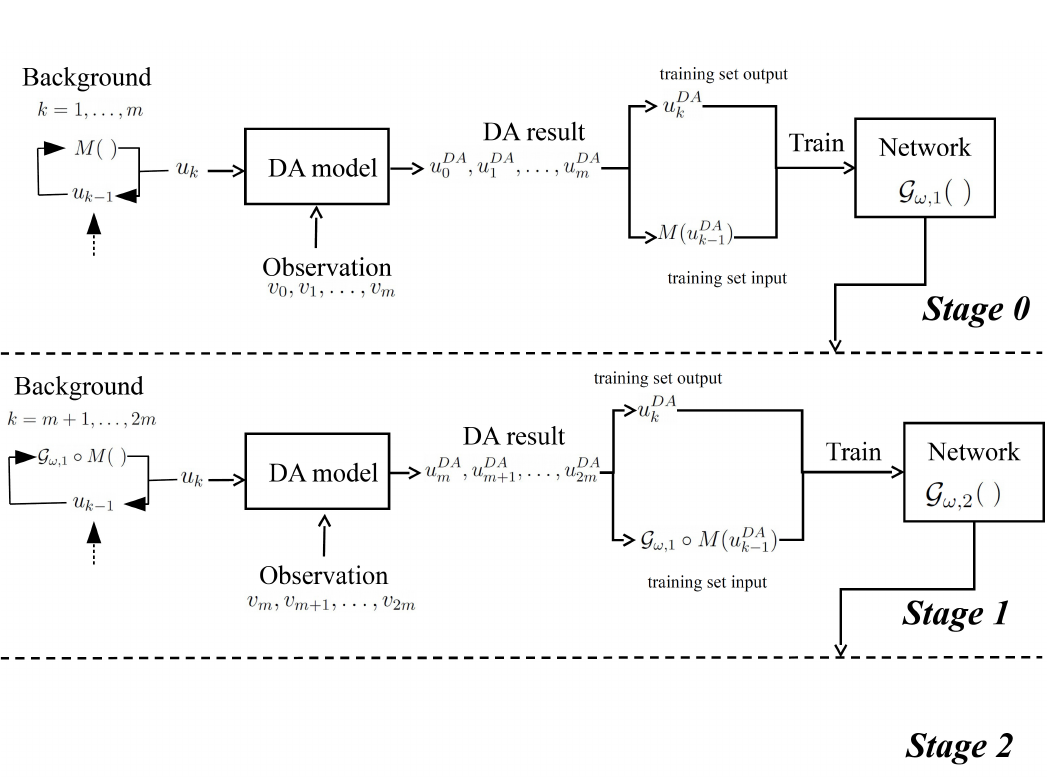
Figure 4. The schematic diagram of